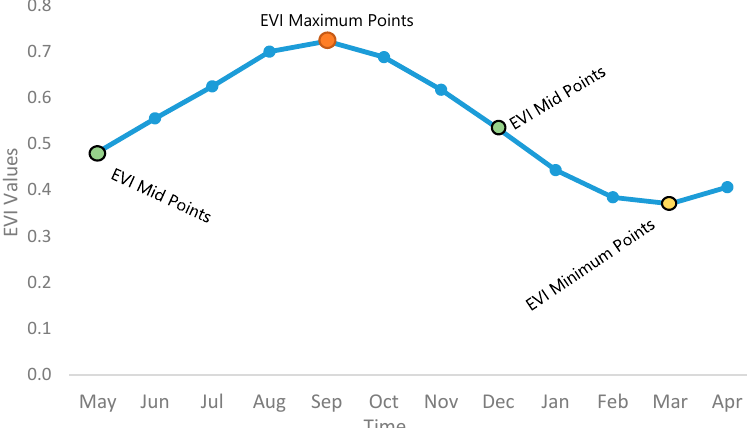
Figure 6. Example of determination of the annual local minimum and local maximum EVI pixel values/points of deciduous forests by indicators of the vegetation leaf-shedding phenology (LSP) and leaf-flushing phenology (LFS).